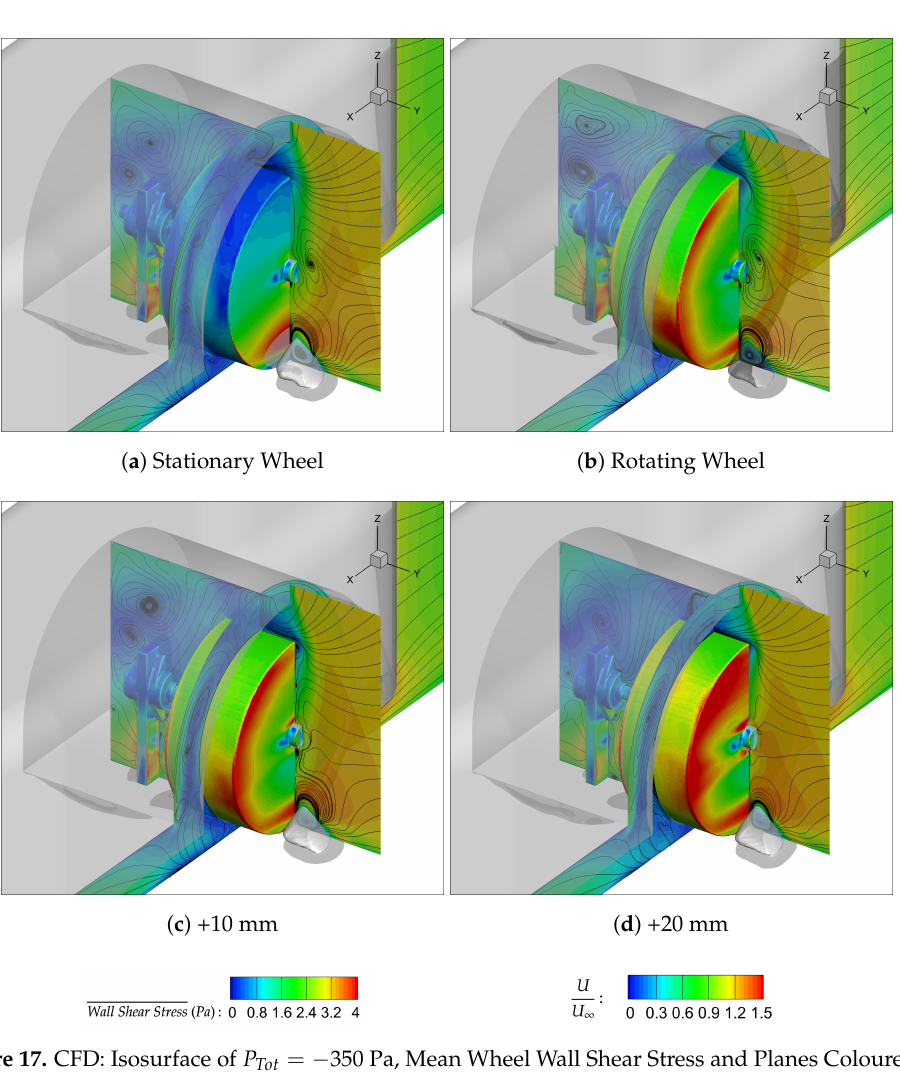
Figure 17. CFD: Isosurface of P Tot = − 350 Pa, Mean Wheel Wall Shear Stress and Planes Coloured by Velocity Magnitude.